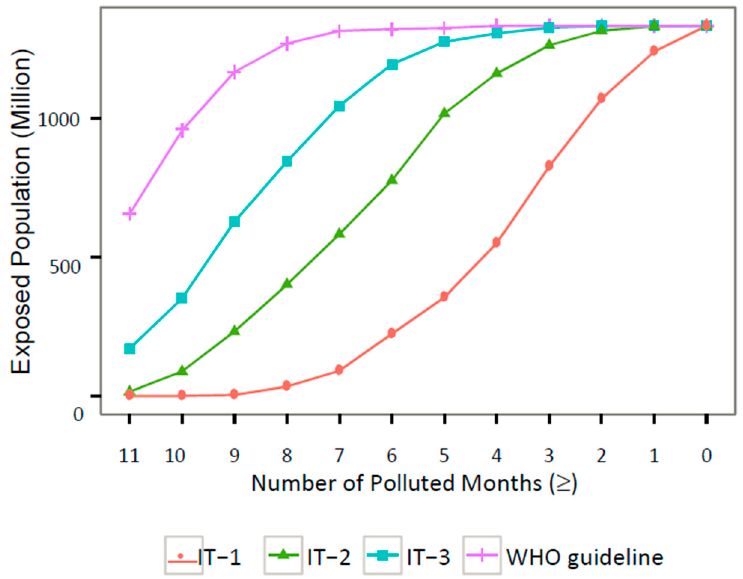
Figure 2. Exposure duration and exposed population under various ambient air quality standards. The x-axis represents exposure duration that measures the cumulative time exceeding certain PM 2.5 standard. The y-axis represents exposed population. Each standard is represented by one colored curve. A dot ( x , y ) on a curve s means that y million people are exposed to PM 2.5 above the standard s for over x months.